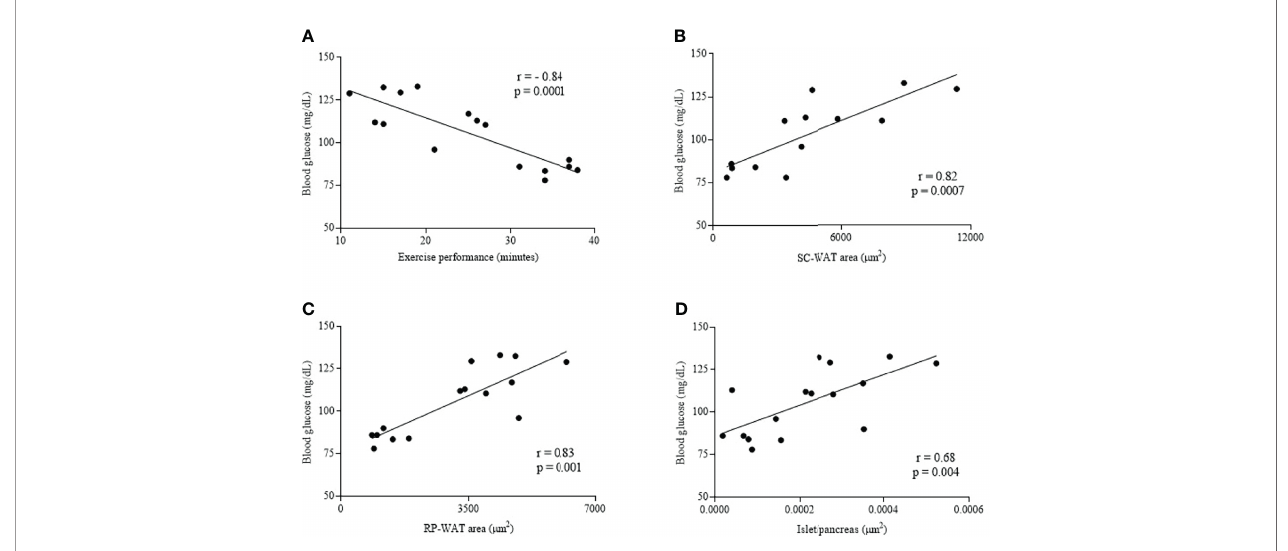
FIGURE 5 | Correlation of fasting blood glucose and exercise performance (minutes) (A) , fasting blood glucose and SC-WAT adipocytes area (B) , fasting blood glucose and RP-WAT adipocytes area (C) and fasting blood glucose and islet area to pancreas area ratio (D) . Wt (n = 5), Lep ob S (n = 4-5) and Lep ob T (n =